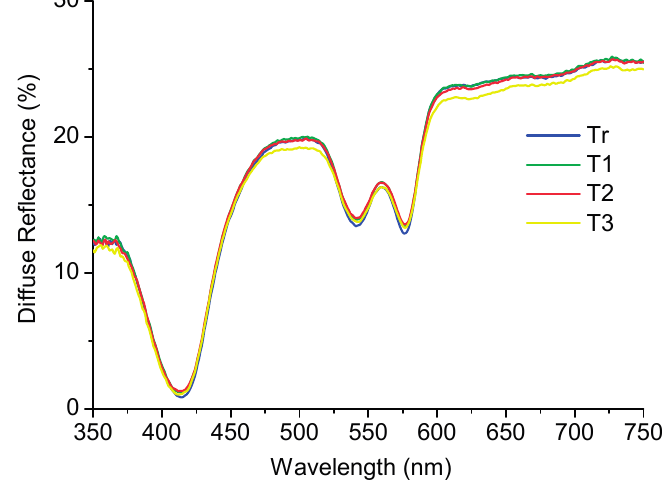
Figure 3. Diffuse reflectance spectra at different temperatures for a test